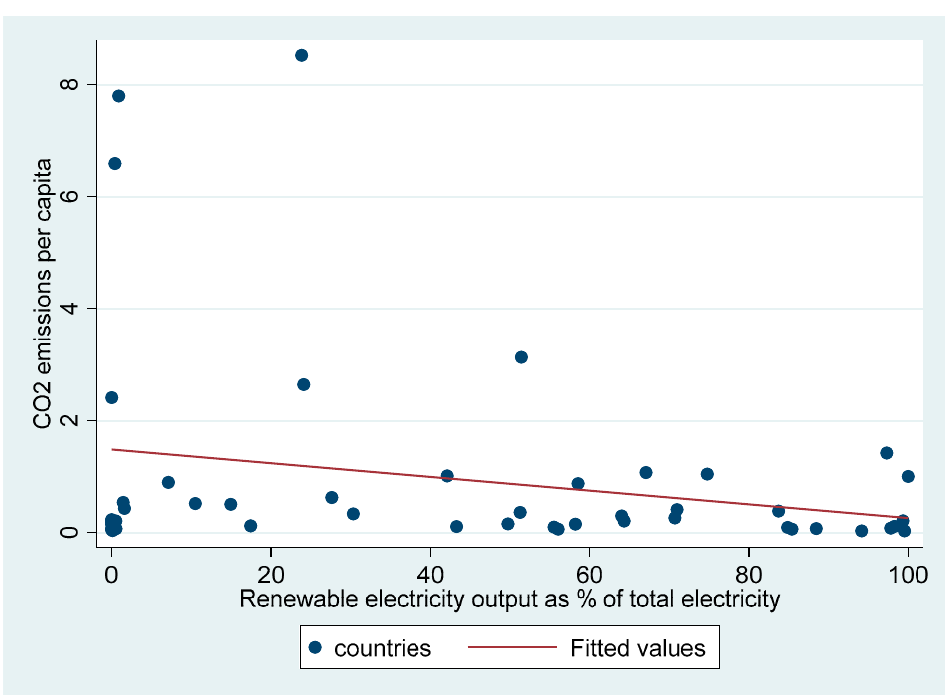
Figure 3. CO 2 emissions and renewable energy output,